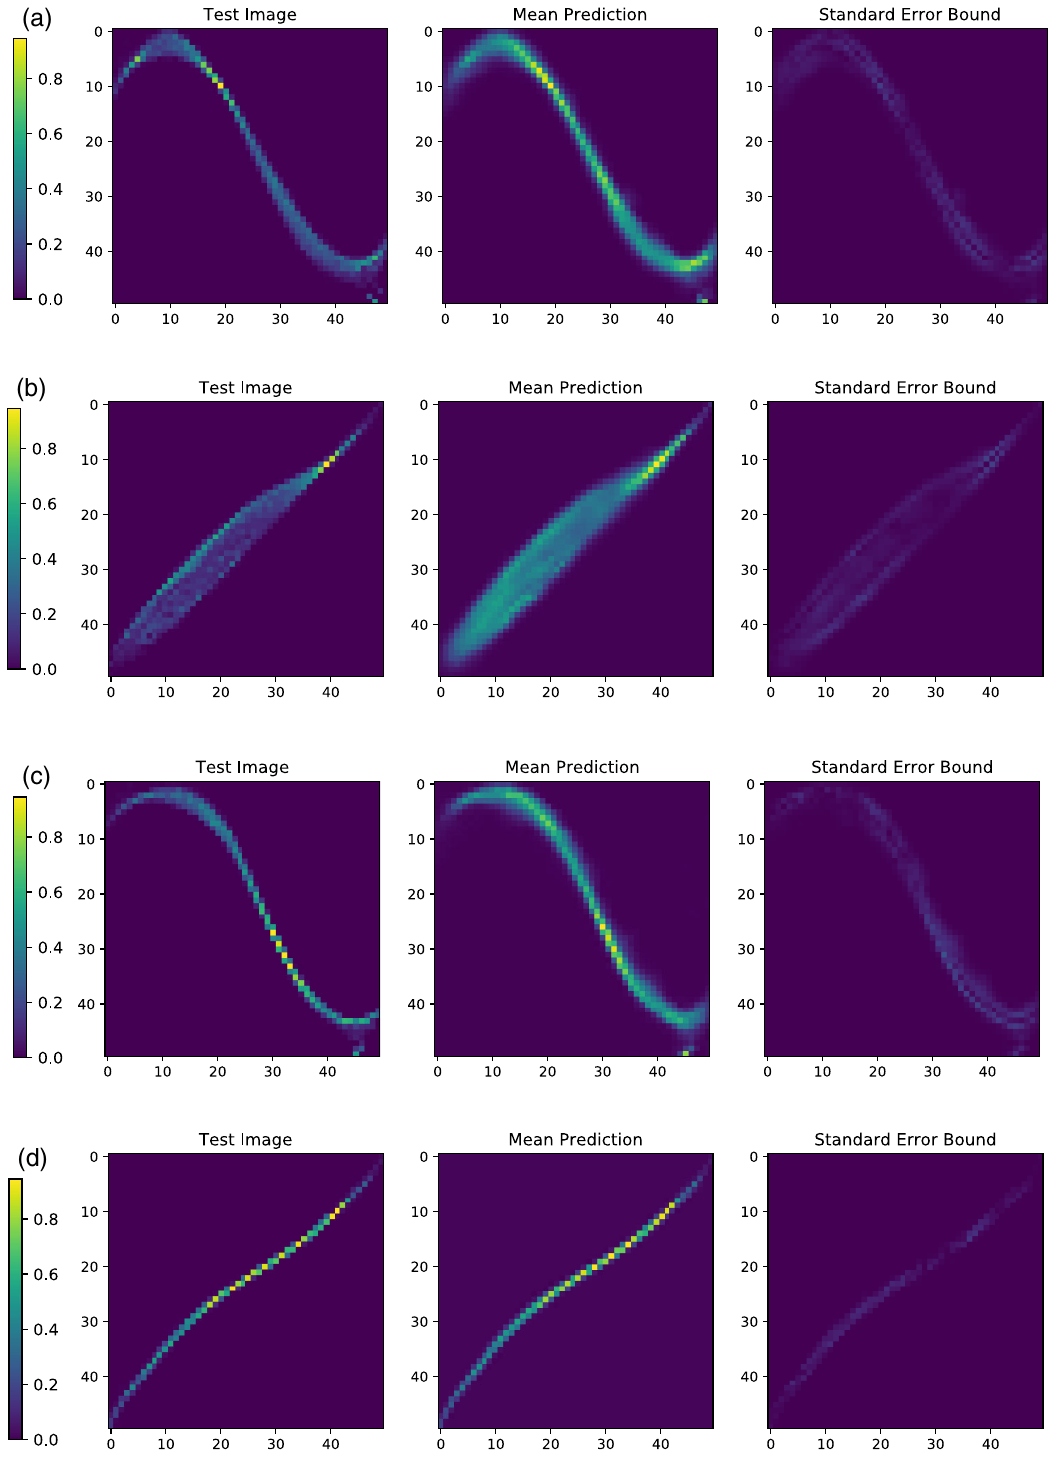
FIG. 13. Simulation test images, neural network ensemble predictions and predicted standard error bounds over the ensemble of deterministic neural networks for the LCLS-II injector longitudinal phase space. (a), (b), (c) and (d) are representative instances, randomly